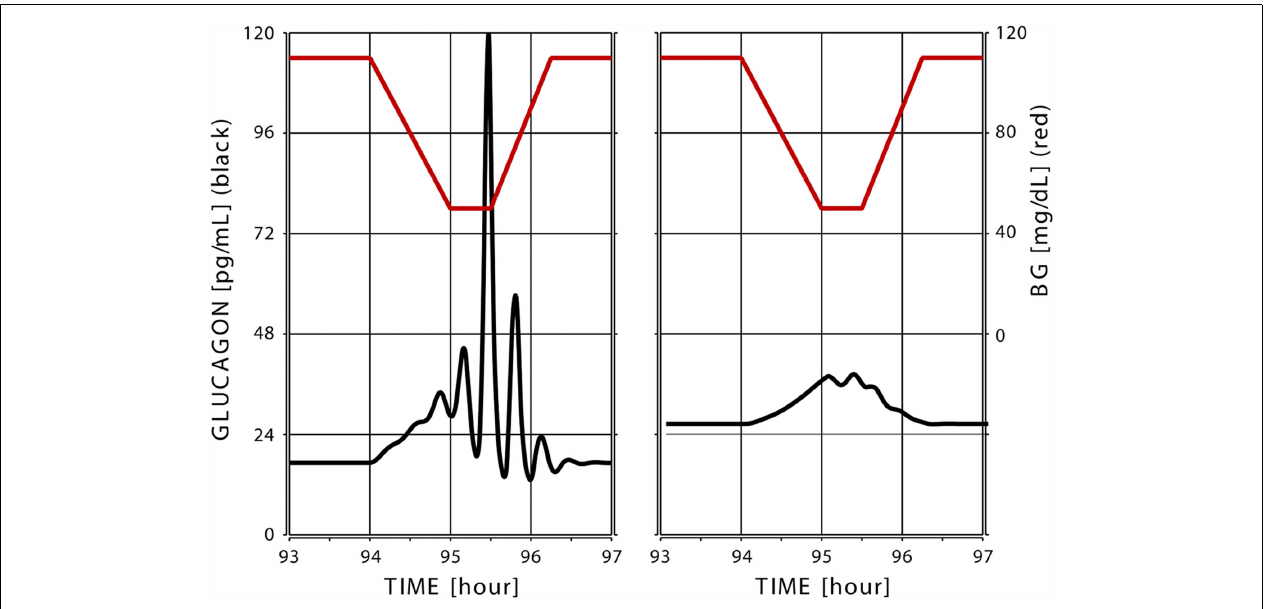
FIGURE 6 | Simulated glucagon response (black) to superimposed hypoglycemia (glucose levels shown in red) in two “ in silico ” subjects with low (left) and high (right) basal glucagon.